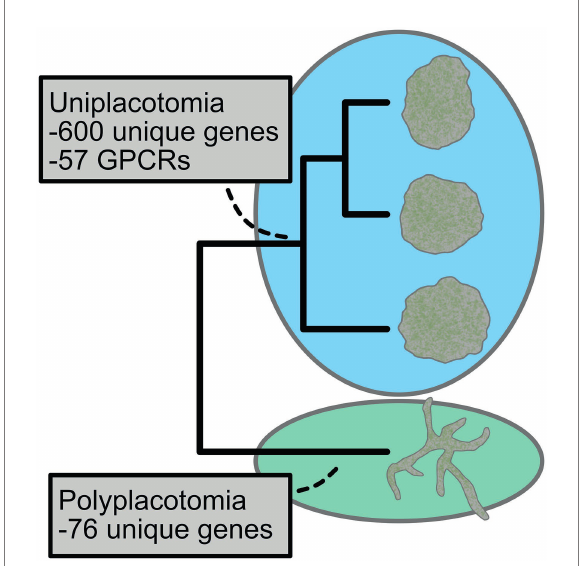
FIGURE 2 An example of molecular morphology in practice. Nearly all lineages of Placozoa look roughly like miniature pancakes (blue circle). Polyplacotoma mediterranea (green circle) is the only species within the phylum that is clearly morphologically distinct. Based on this single morphological trait difference, it would be easy to mistake Placozoa as a non-diverse group. However, this is not the case. While we arbitrarily depict three lineages in blue, there are at least two dozen cryptic species (with many more presumed to exist) and they are highly divergent genetically. To make a backbone higher taxonomy for Placozoa, our recent study used molecular morphology ( via gene content) to clarify the size of the difference between lineages (Tessler et al., 2022). As 600 uniquely present genes were found for the main clade of Placozoa and 76 uniquely present genes were found for P. mediterranea , the two lineages were classified at the class level (which was also supported by a time-calibrated phylogeny). The uniquely present genes included functionally relevant genes, such as the 57 GPRs labeled above. Uniquely present, in this case, means orthologs that were only found in those